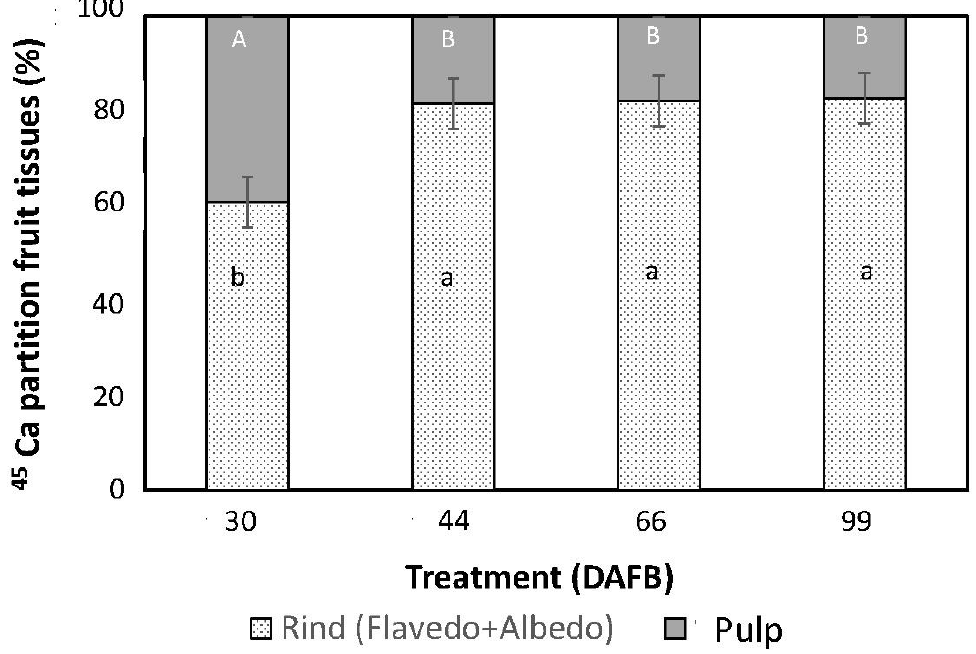
Figure 1. 45 Ca partition at fruit harvest, pulp and rind (flavedo + albedo). Treatment: 5µL 45 Ca application 30, 44, 66, and 99 days after full bloom (DAFB). Different capital and lower case letters indicate statistically significant differences ( p ≤ 0.05) between treatment dates. Capital letters refer to differences regarding the rate of 45 Ca partition in the pulp, and lowercase letters are associated with the rate of 45 Ca partition in the rind.